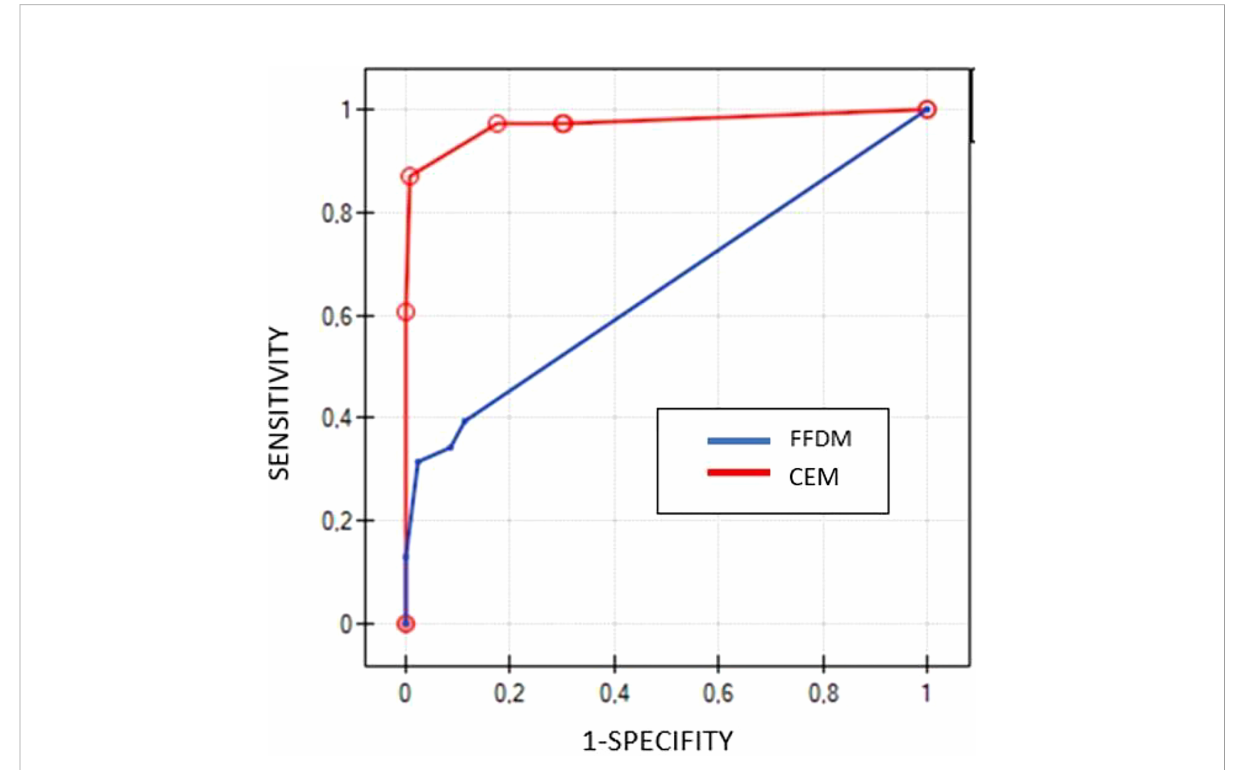
FIGURE 2 Comparison of ROC curves for CEM (red line) and FFDM (blue line) based on BIRADS